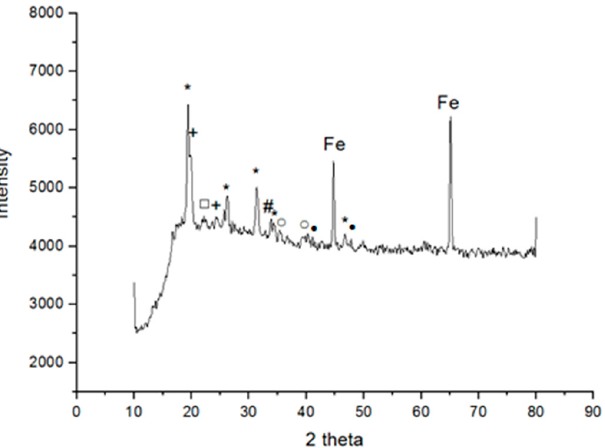
Figure 9. Diffractogram of unpainted phosphate coating.